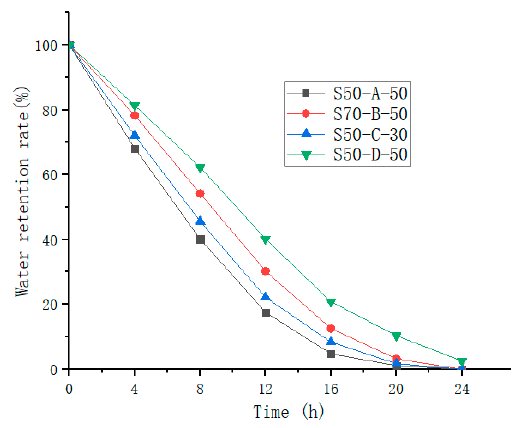
Figure 7. Water retention rate of water-retentive mortar at different times.